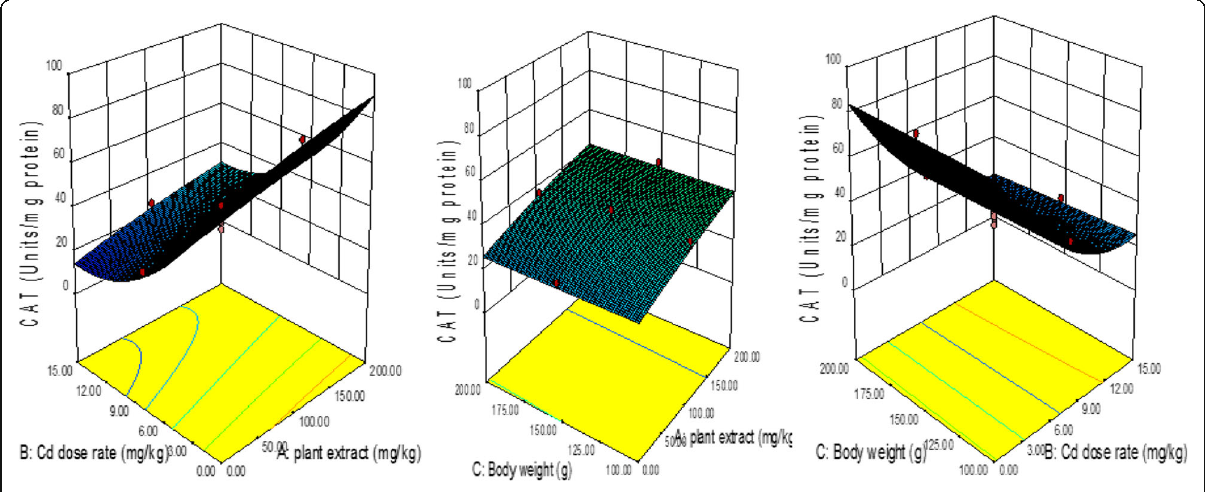
Fig. 4 3-D surface plots for serum CAT activity under the influence of process